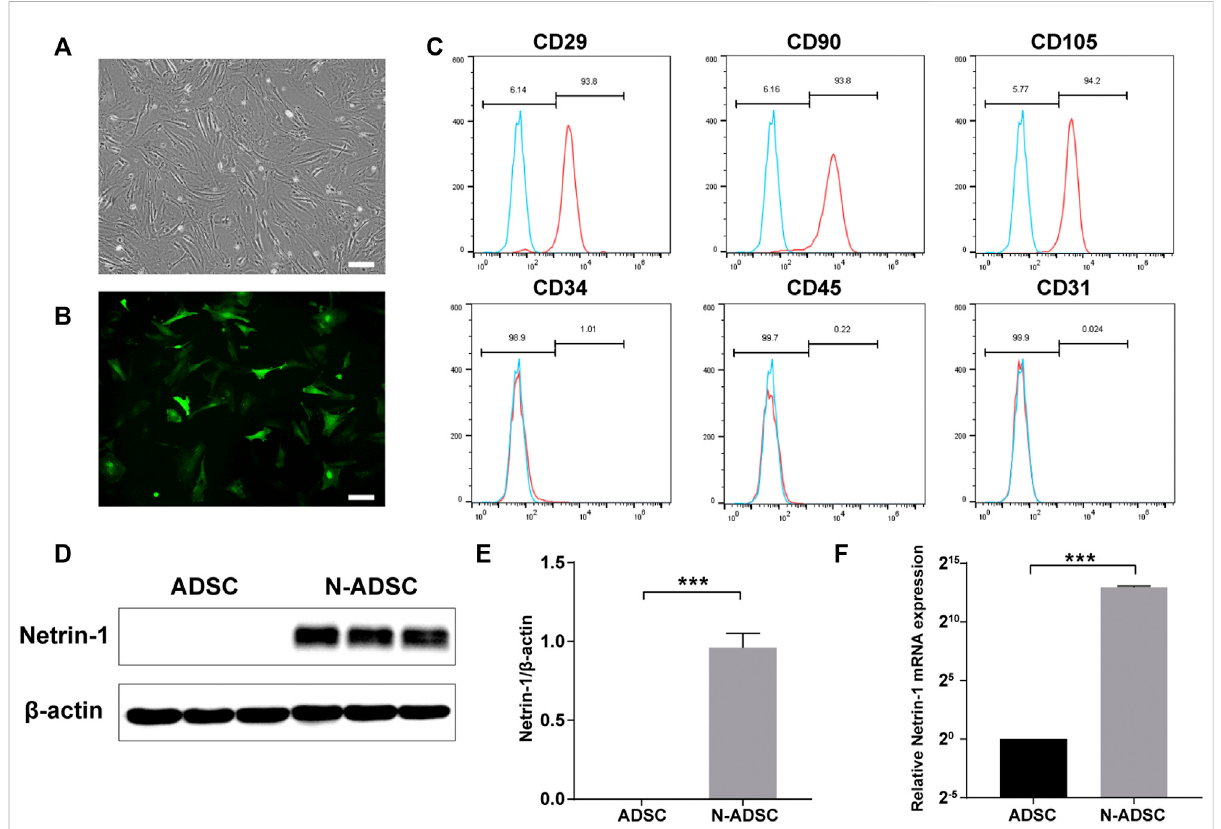
FIGURE 3 Characterization of ADSCs and N-ADSCs. (A) P3-ADSCs were examined under the microscope. (B) N-ADSCs were examined under a fl uorescence microscope. (C) Identi fi cation of ADSC surface markers using fl ow cytometry. (D,E) Western blot and (F) RT-qPCR analyses provedthe overexpression of Netrin-1 in the N-ADSCs. *** p < 0.001. Scale bar = 100 μ m. P3, passage 3; N-ADSCs, Netrin-1-modi fi ed adipose-derived stem cells.